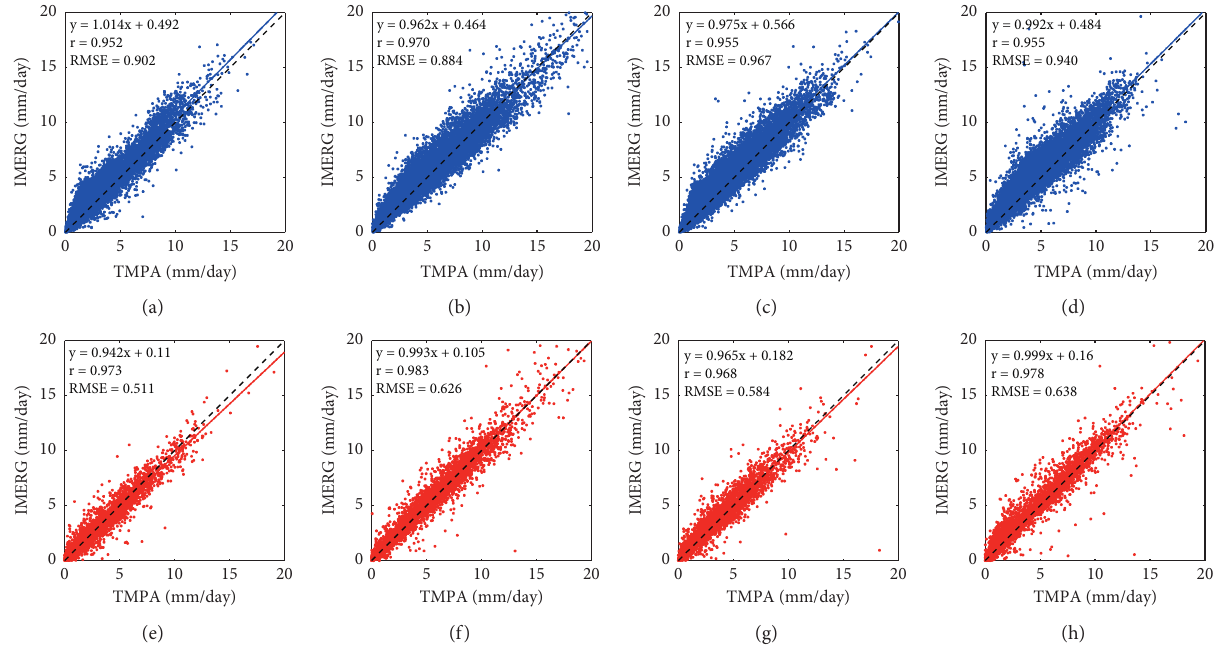
Figure 3: Scatter plots of seasonal mean precipitation in the IMERG V06B and TMPA 3B42 products over ocean (blue) and land (red) using a 1 ° × 1 ° grids for (a, e) spring; (b, f) summer; (c, g) autumn; and (d, h) winter. The black dashed line indicates a one-to-one relationship.